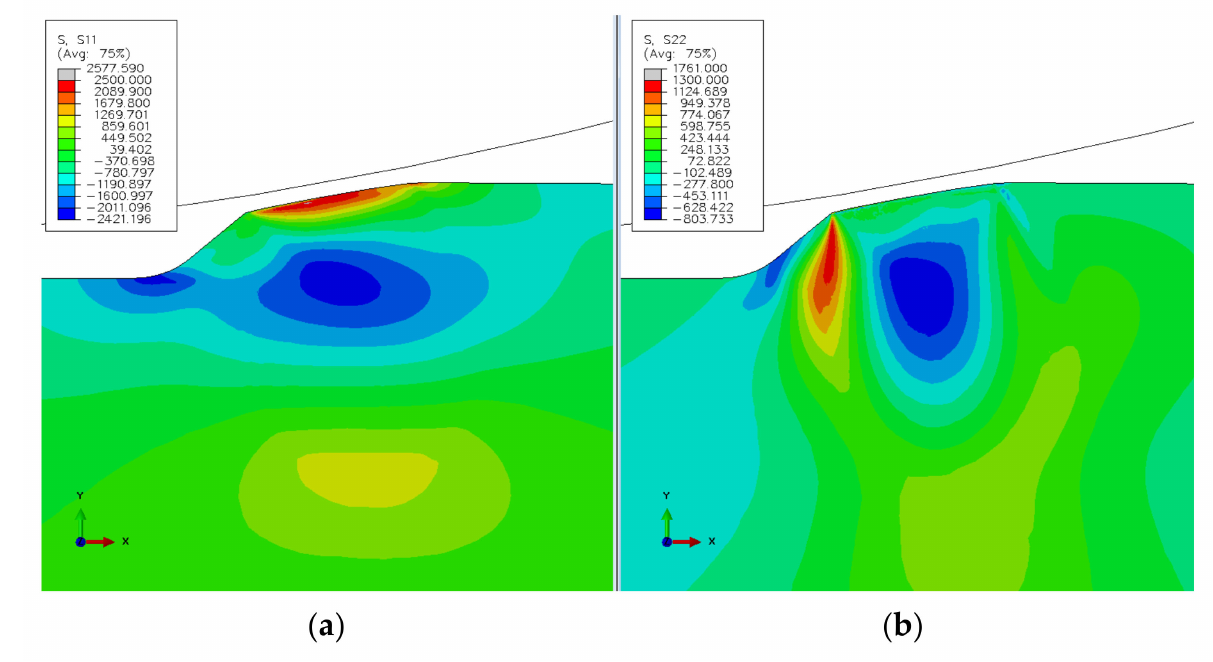
Figure 6. Simulated residual stresses ( a ) in the horizontal direction x, and ( b ) in the vertical direction y, in the unloading